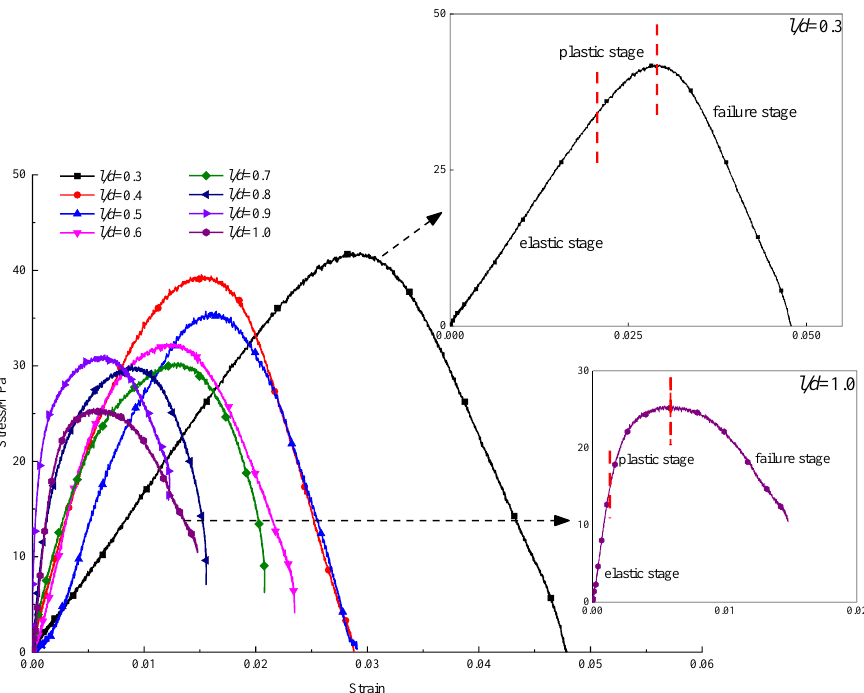
Figure 5. Stress-strain curves of coal with different l / d .